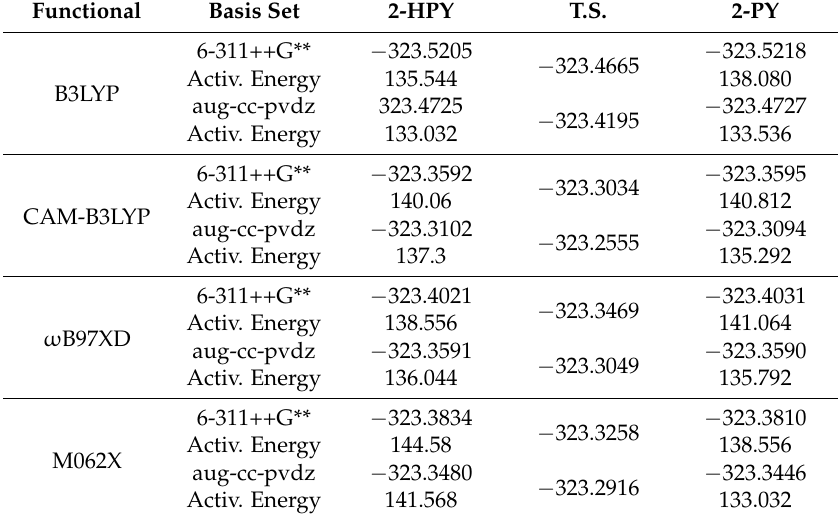
Table 2. The total zero-point energy (a.u.) of 2-HPY, T.S. and 2-PY forms and activation energies (kJ/mol) of 2-HPY and 2-PY tautomers using different functionals with 6-311++G** and aug-cc-pvdz basis sets.